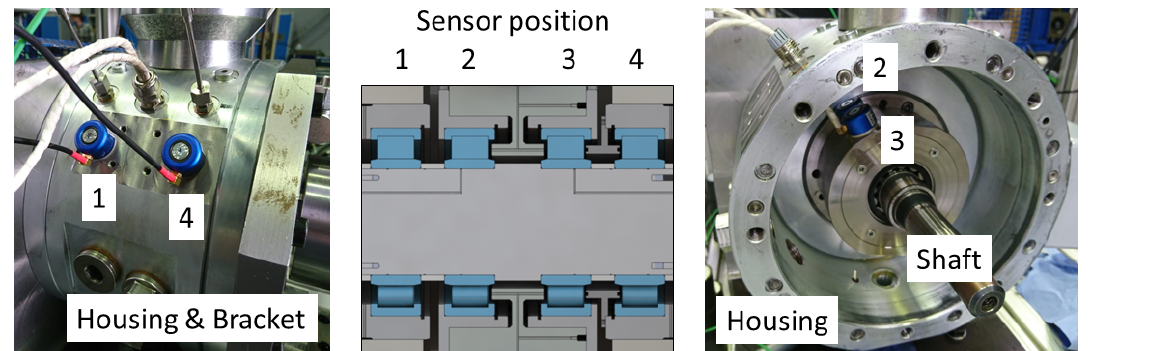
Figure 4. Four-bearing test bench (RLP): position of the installed AE